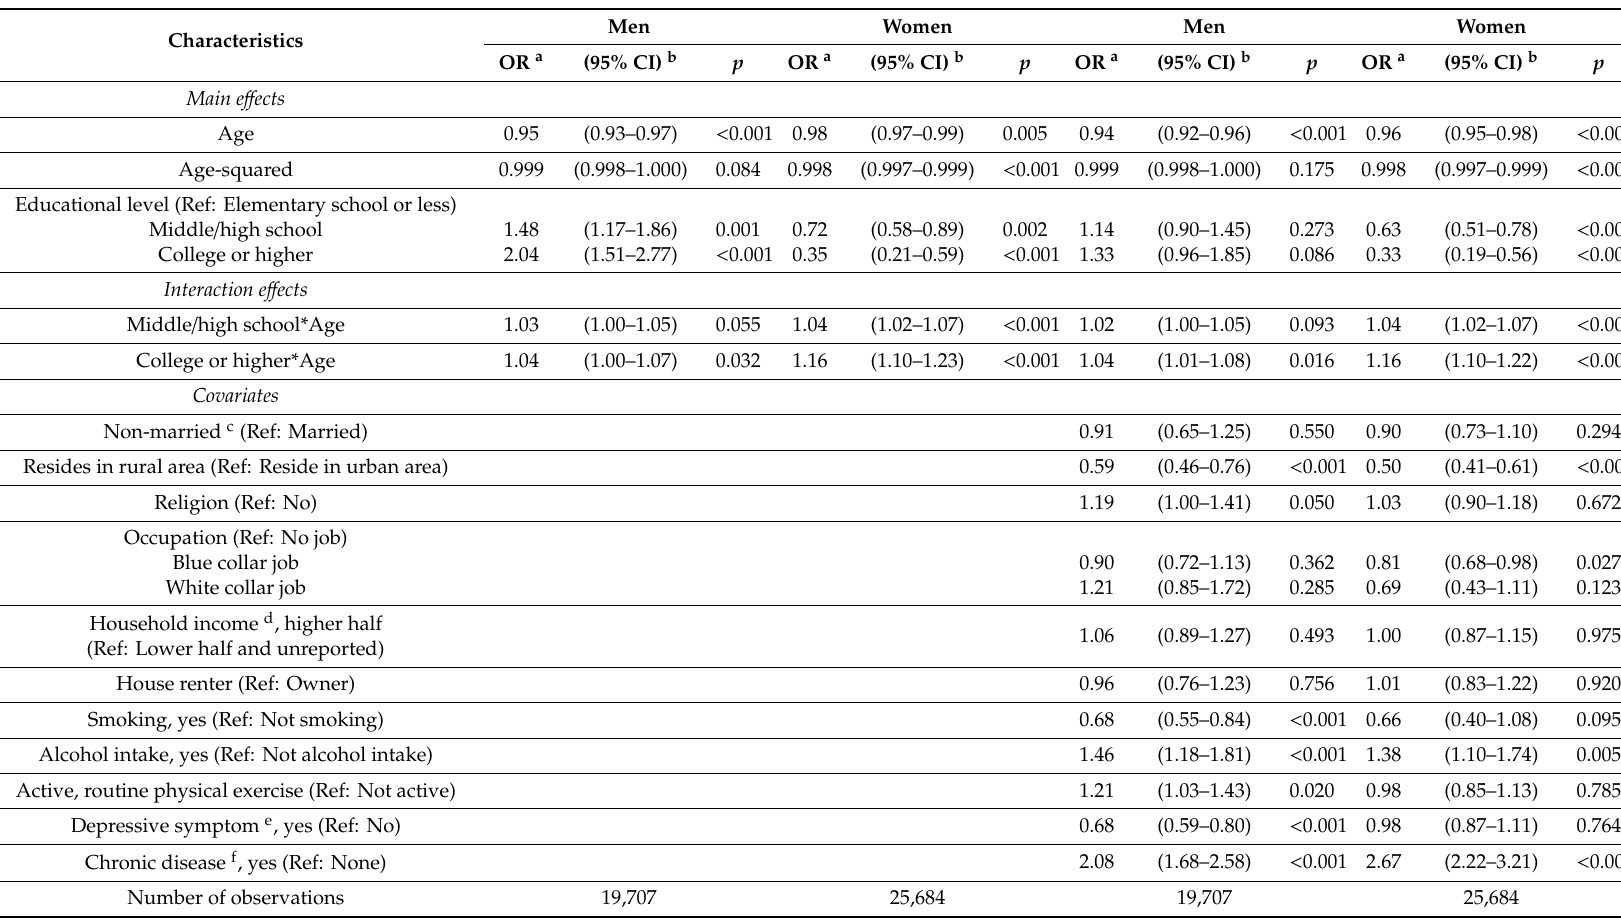
Table 3. Longitudinal analyses of the associations of age and education with obesity risk by gender.